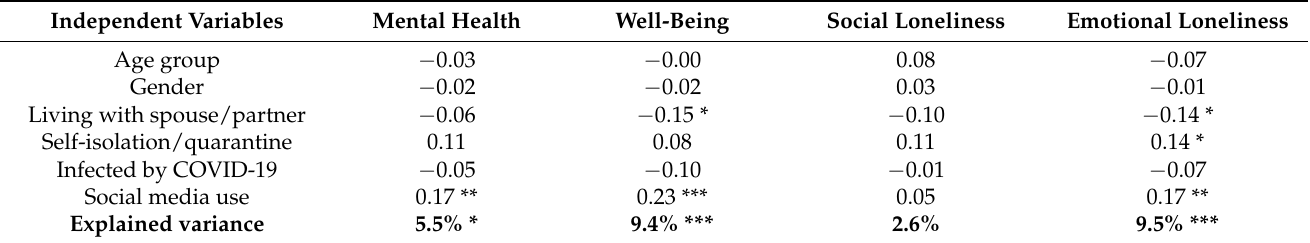
Table 5. Associations with mental health outcomes among students ( n =